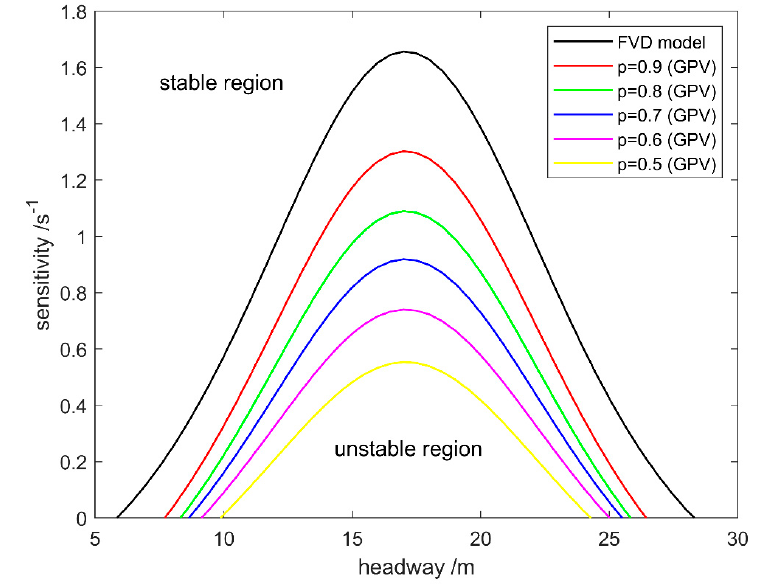
p compared with that of the